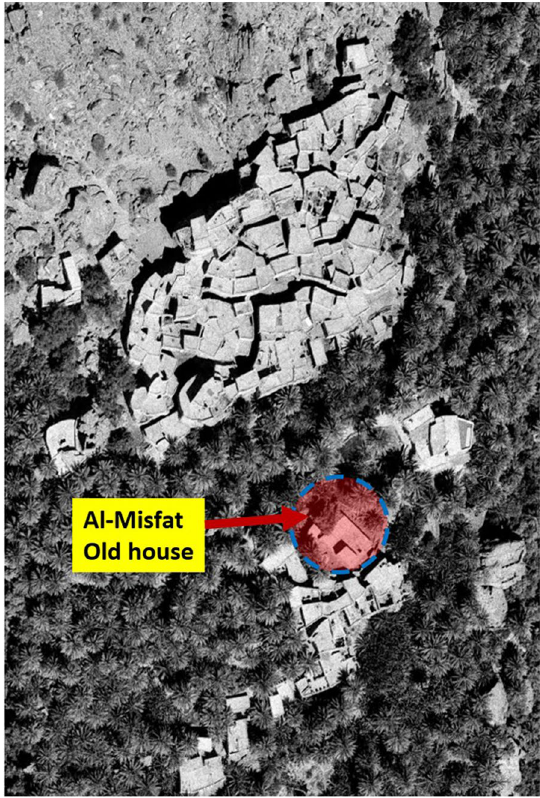
Fig. 5 Al-Misfat Old House location (Source: Bandyopadhyay, Soumyen, and Giamila Quattrone 2016, enhanced by the author)